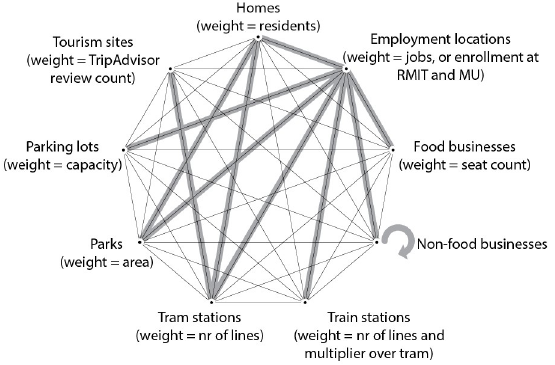
Fig 3. Potential 36 origin-destination pairs for pedestrian trips in Melbourne. Gray highlights include the ten O-D pairs for which trips were modeled. Weights describe which attribute was used as origin or destination weight in the analysis.